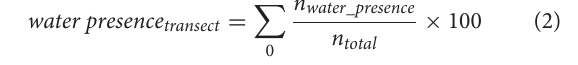
Frontiers in Water |